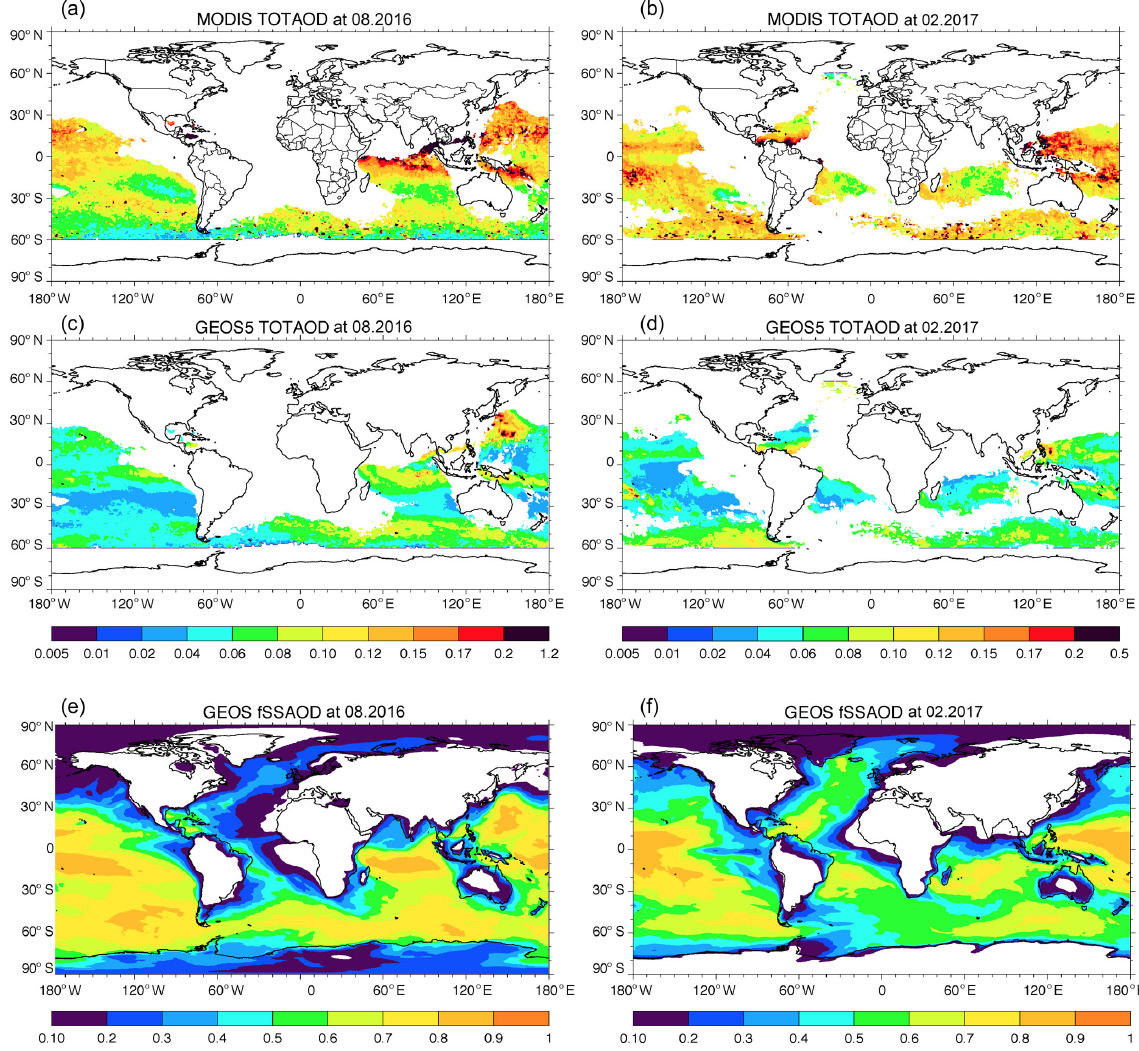
Figure 4. Total aerosol AOD in August 2016 (a, c) and February 2017 (b, d) from MODIS (a, b) and GEOS (c, d) . Panels (e, f) show the AOD fraction of sea salt relative to the total aerosol simulated by